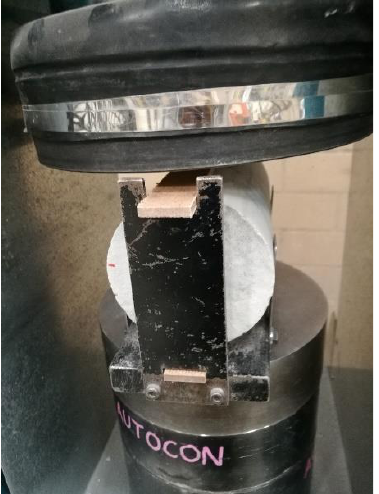
Figure 2. Indirect tensile test setup.